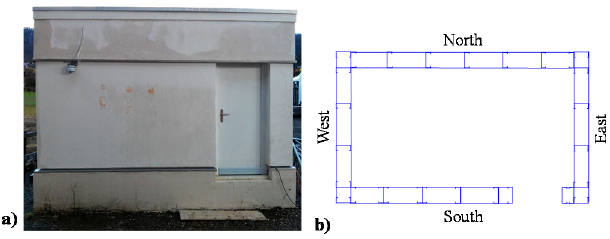
Figure 1. The mock-up building. ( a ) Front view of the building (south wall) and ( b ) floor plan (section of the load-bearing structure).